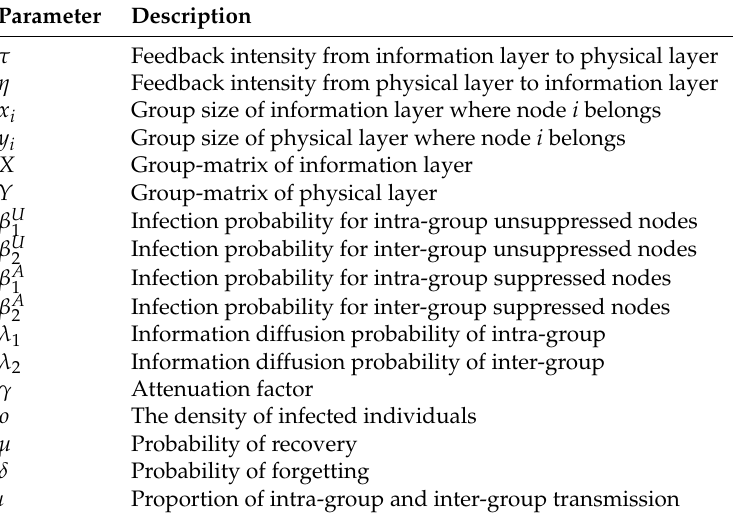
Figure 1. Schematic diagram of a coupled group-based bilayer network. The upper (lower) layer stands for the information diffusion (epidemic spreading), where each node in the information (physical) layer only has two possible states: aware (A)and unaware (U) [susceptible (S) and infected (I)]. τ ( η ) represents the feedback intensity from information (physical) layer to physical (information) layer. The nodes in the same color belong to the same group in each layer. Table 1. The description of the related key